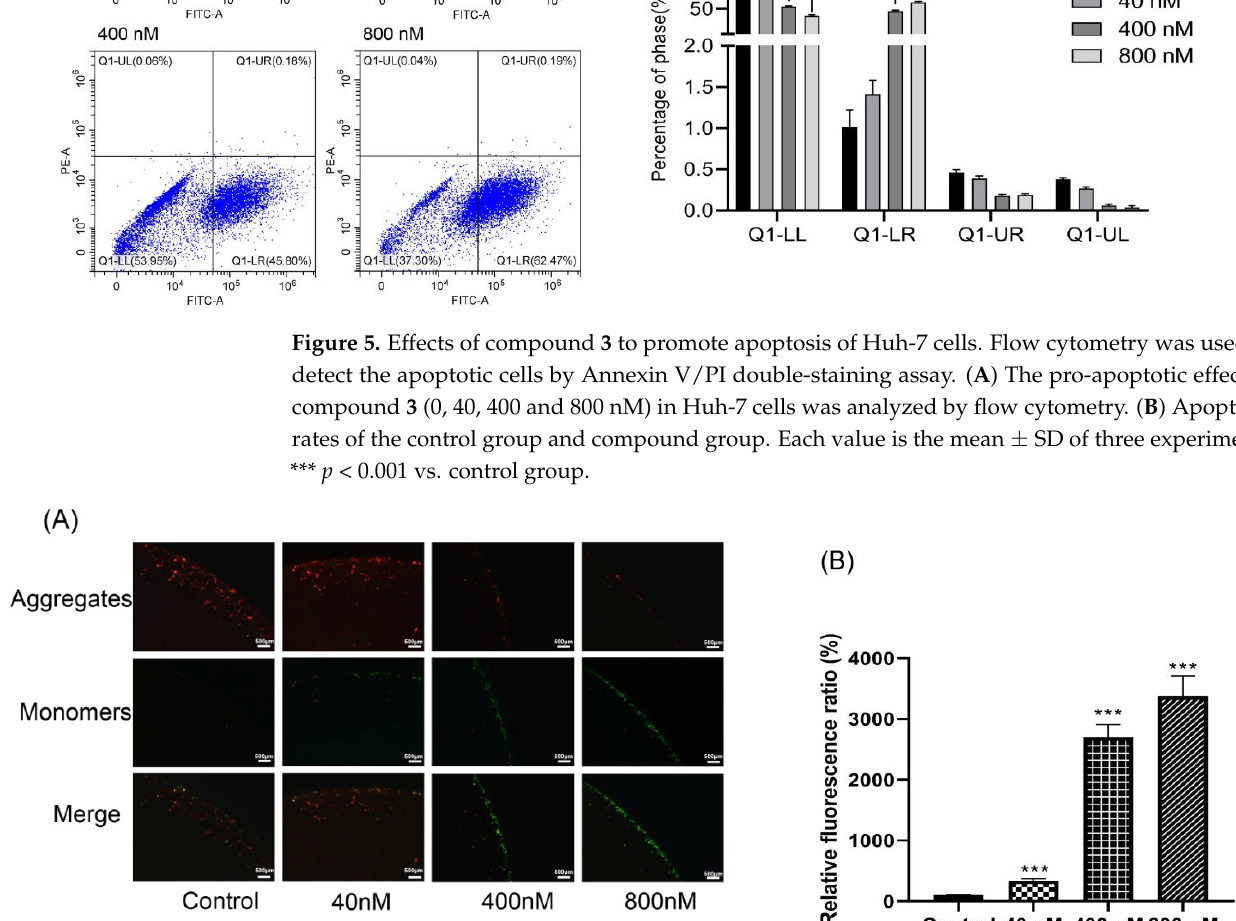
Figure 6. ( A ) Changes in mitochondrial membrane permeabilization in compound 3 treated Huh-7 cells by fluorescence microscopy. ( B ) The level of ROS after treatment with 0, 40, 400 and 800 nM of 3 for 24 h. The average levels of ROS were expressed as mean ± SD from three different experiments. *** p < 0.001 vs. control values.